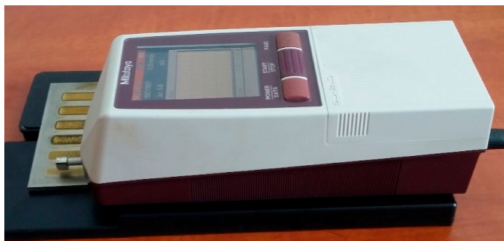
Figure 2. A view of the portable surface roughness tester SJ-210 Surftest Mitutoyo during measurements of roughness on the surface of stringer beads produced by laser gas nitriding of titanium alloy